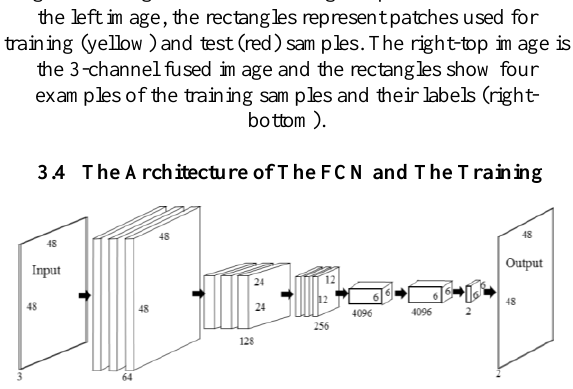
Figure 5. The architecture of the adopted FCN which is shorter than the original